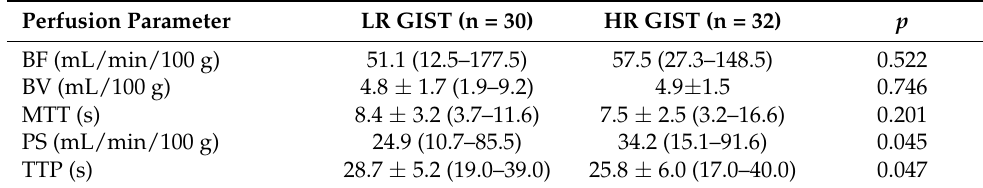
Table 2. CT perfusion parameter values of gastric GIST in the HR and LR